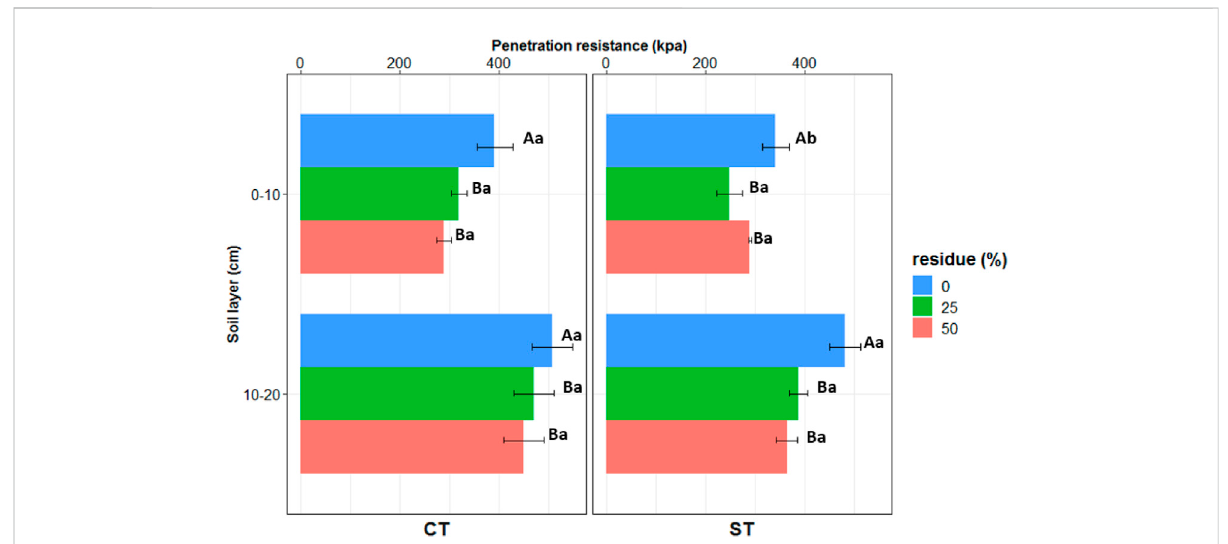
FIGURE 4 Effect of tillage and crop establishment (TCE)techniques and residue management(R) options on soil penetration resistance (KPa) at 0 – 10 and 10 – 20 cm pro fi le depths at maize harvest in 2020 – 21. For treatment, details refer to Table 2. Different upper-case letters represent signi fi cant intragroup statistical difference at p ≤ 0.05; Different lower-case letters represent signi fi cant intergroup statistical difference at p ≤ 0.05; p values calculated by the ANOVA test and t